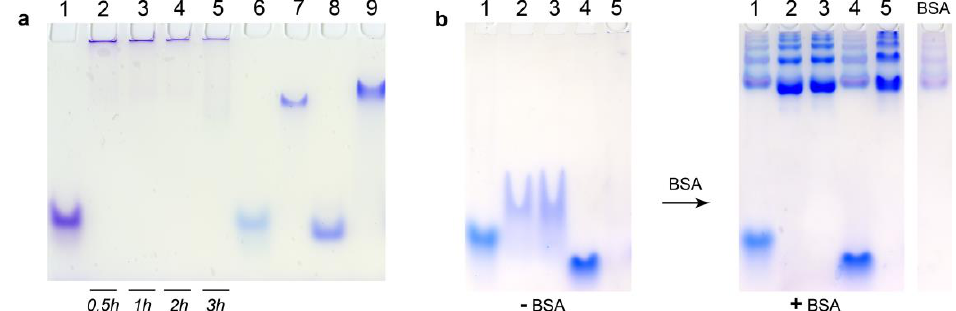
Figure 4. Comparative electrophoretic mobilities of control oligonucleotides and dodecyl oligonucleotide conjugates. ( a ) 17 (Lane 1), D-17 PG * (Lanes 2–5), 13 (Lane 6), D-13 PG (Lane 7), 22 (Lane 8), D-22 PG (Lane 9) investigated by electrophoretic mobility shift assay (EMSA) in non-denaturing 6.5% PAAG after 3 h* incubation in TAM buffer, at 25 ◦ C; each sample contained 20 µ M of the oligomer. ( b ) 13 (Lane 1), D-13 (Lane 2), D-13 PG (Lane 3), 17 (Lane 4), D-17 PG (Lane 5) investigated by non-denaturing 8% PAGE